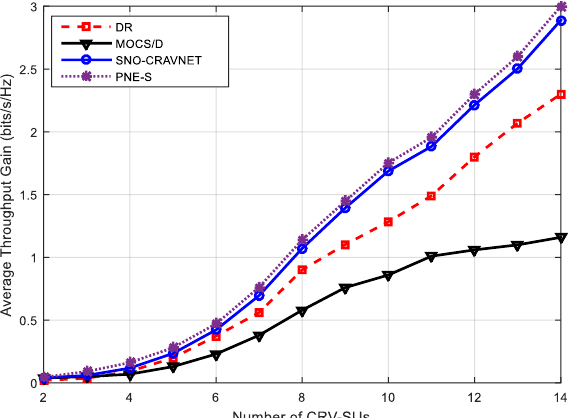
Figure 5. Performance evaluation using the overall achieved average throughput gain measured against the varying number of CRV-SUs.